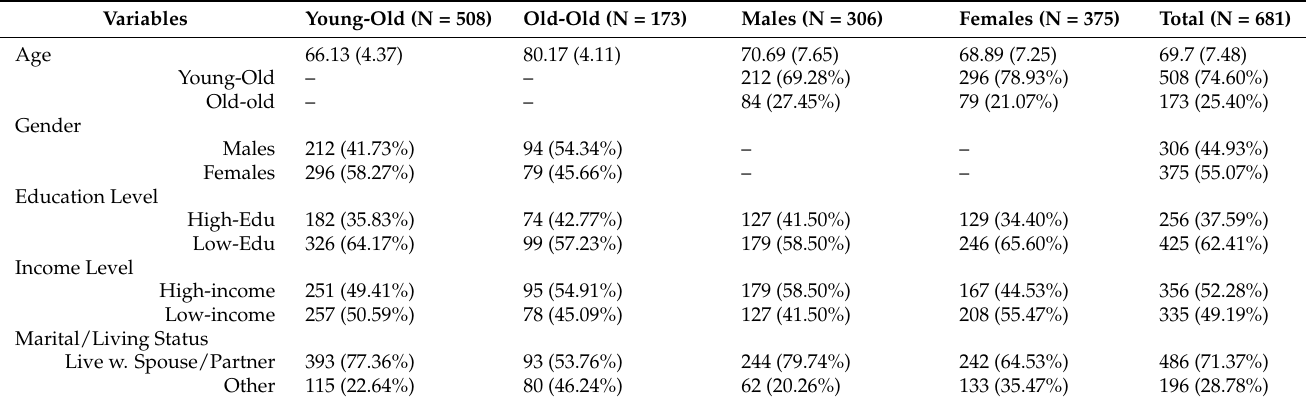
Table 1. Sample characteristics by age and gender.